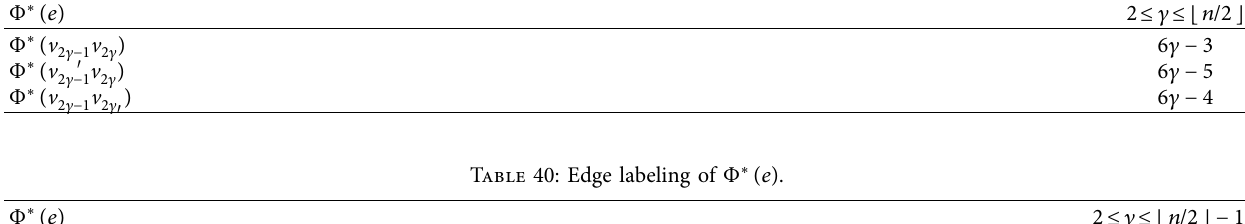
Table 39: Edge labeling of Φ ∗ ( e ) .